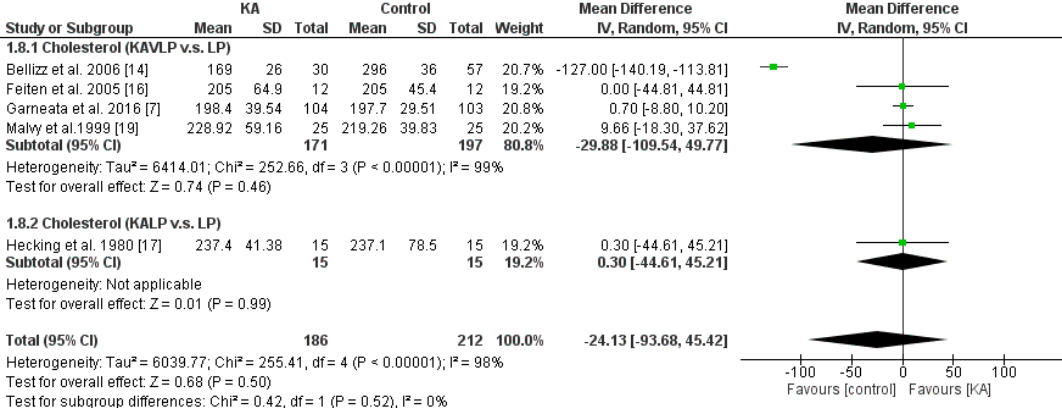
Figure 9. Forest plot of effects of KA on serum cholesterol level in patients sub-grouped by the type of restricted protein diet. The random-effects model was utilized. KAVLP: very-low-protein diet supplemented with ketoanalogues. KALP: low-protein diet supplemented with ketoanalogues. LP: low-protein diet.